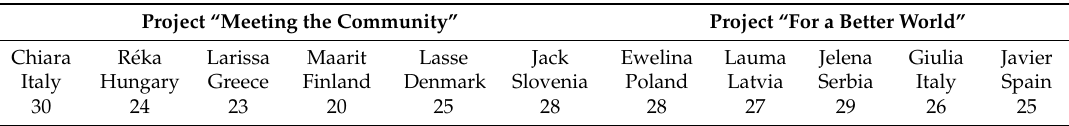
Table 1. Young volunteers’ ages and home